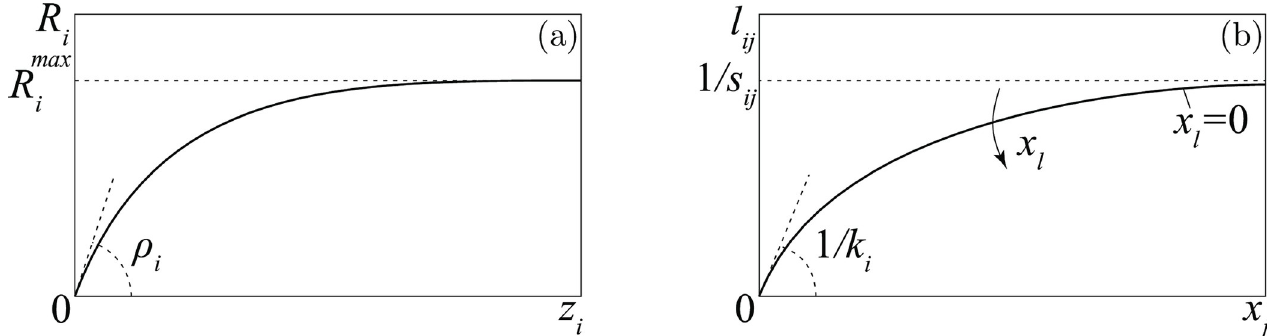
Fig 1. The two functions involved in the model. (a) recruitment policy (see Eq (2)); (b) military characteristic (see Eq (3)).